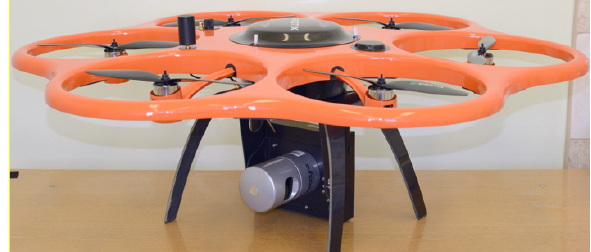
Figure 3 . Aibot X6 V2 with Velodyne HDL-32E laser scanner.